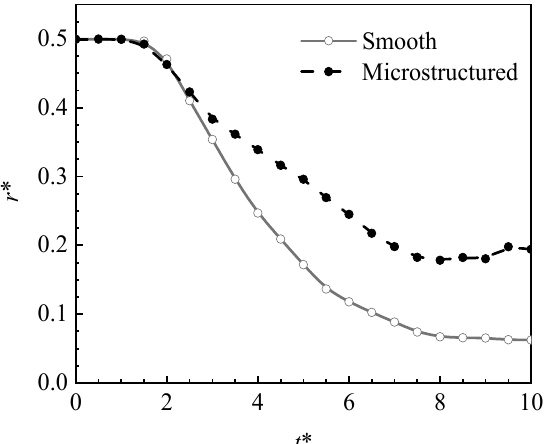
Figure 17. Variation in residual radius of vaporized droplet on the smooth and micro-structured surfaces, respectively.